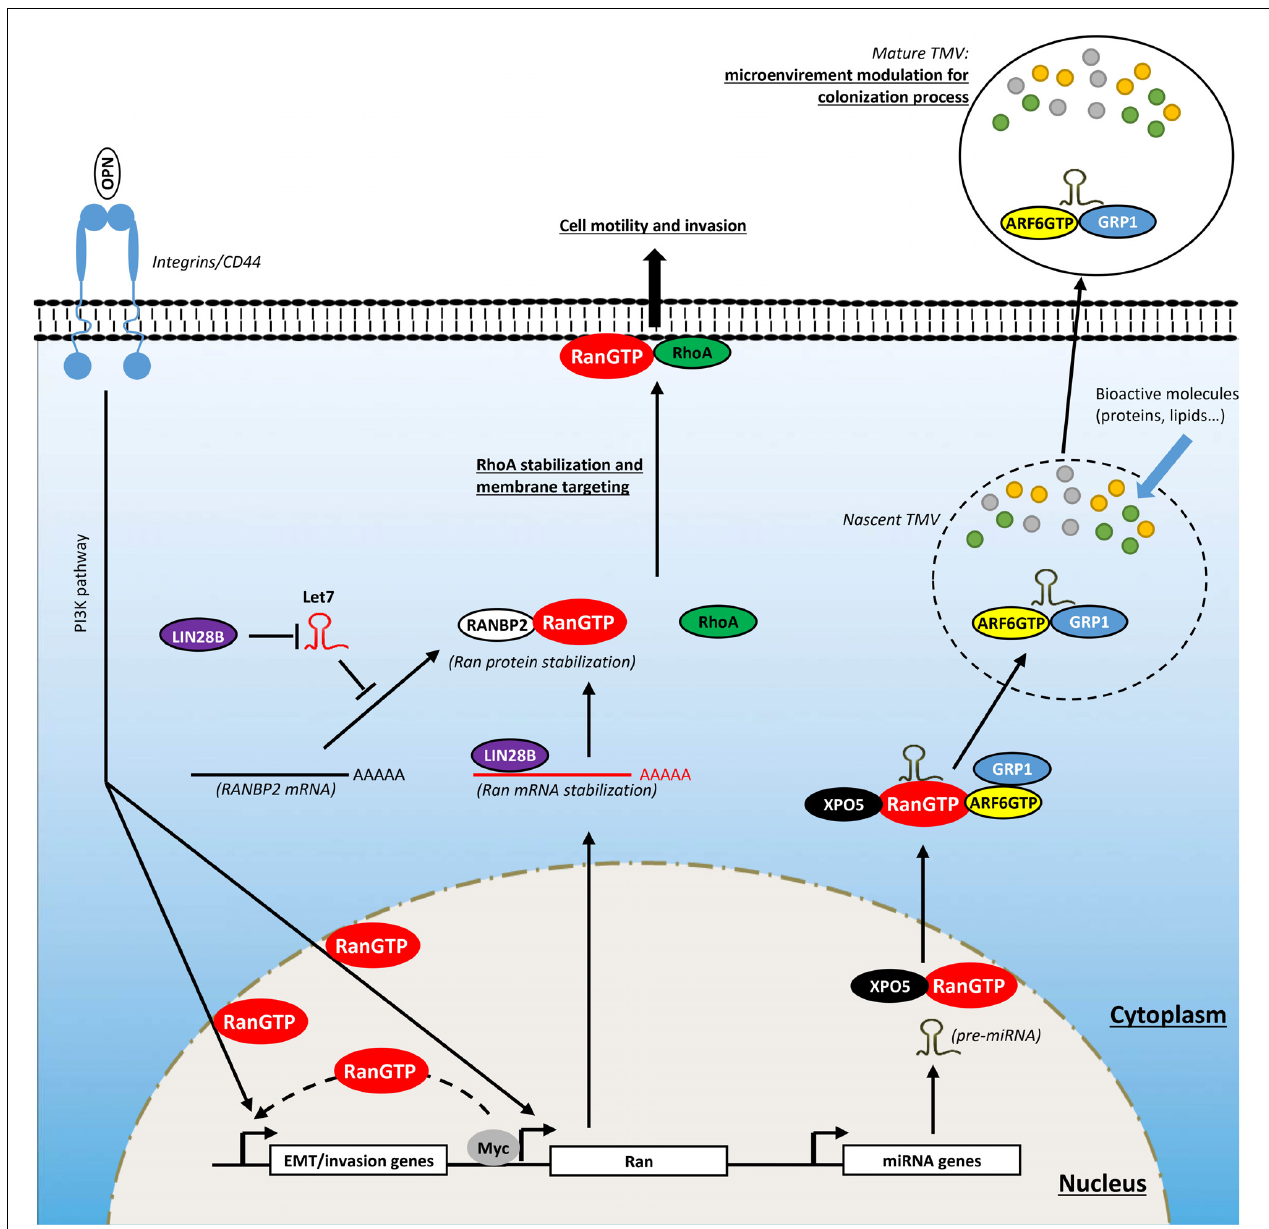
FIGURE 4 | Involvement of Ran in activating invasion and metastasis. Ran, through direct and indirect interactions with oncogenes, is involved in cell invasion. Myc, which is overexpressed in several cancers, interacts directly with the promoter of Ran and induces its expression. The LIN28B oncogene stimulates the expression of Ran directly through the stabilization of its mRNA by direct interaction and indirectly the destabilization of Let7 which is known to destabilize Ran protein through RANBP2 degradation. The induction of Ran promotes cell invasion by different ways: (1) by inducing epithelial-to-mesenchymal transition (EMT); (2) by mediating the invasive signals originating from osteopontin (OPN), Myc, and LIN28B; (3) by stabilizing and targeting RhoA to the plasma membrane; and (4) by delivering oncogenic cargo such as pre-miRNAs to nascent tumor-derived microvesicles